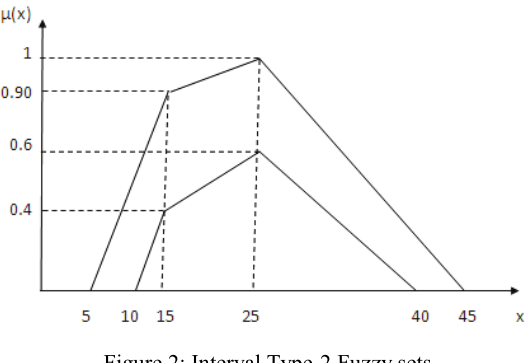
Figure 2 represents a sample trapezoidal interval type-2 fuzzy set